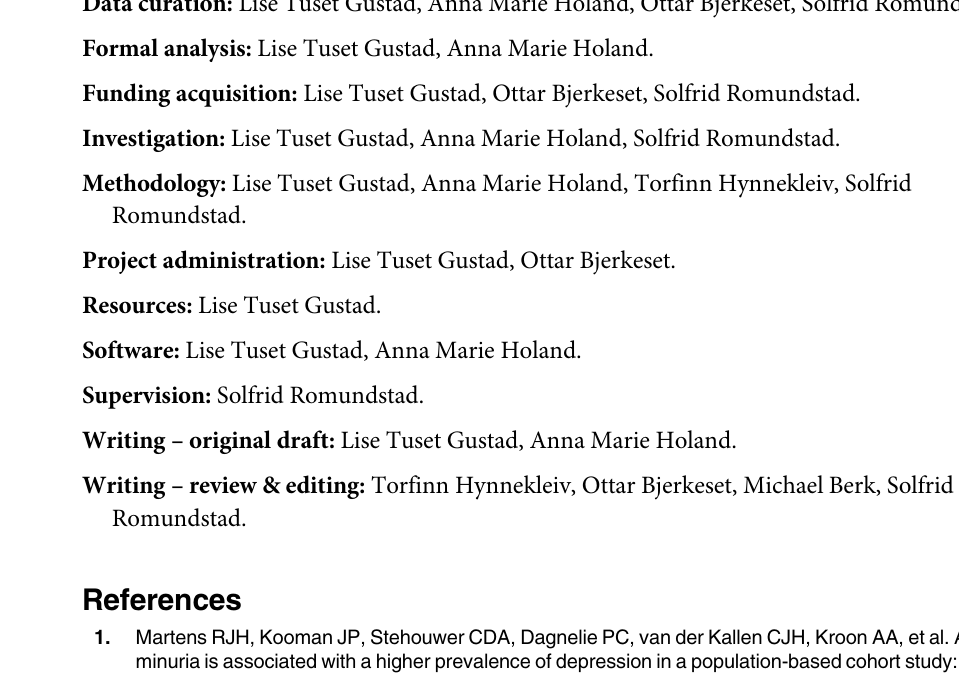
S1 Table. General linear regression results in complete data set. S2 Table. Analysis of Variance (ANOVA) for the covariates in HUNT2 explaining albu- minuria or depression in HUNT3. S3 Table. Sensitivity analysis for the imputed data for model 3 with depression for HUNT 3 as